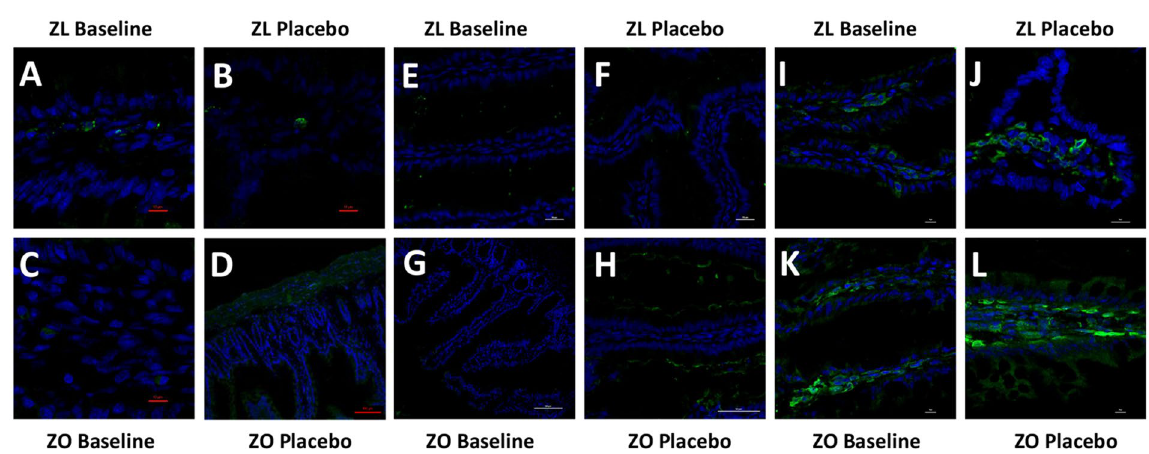
Figure 2. Immunofluorescence analysis of Adamdec1, Ednrb and Ptgs1 proteins from Zucker-lean + / fa and Zucker-Lepr fa / fa rats both at baseline and after 30 days of placebo administration. Panels A–D show results for Adamdec1. Panels E–H show results for Ednrb. Panels I–L show results for Ptgs1. The green color corresponds to Alexa Fluor 488 dye. ZL, Zucker lean Lepr + / fa rats; ZO, Zucker-Lepr fa / fa rats. n = 4 rats per